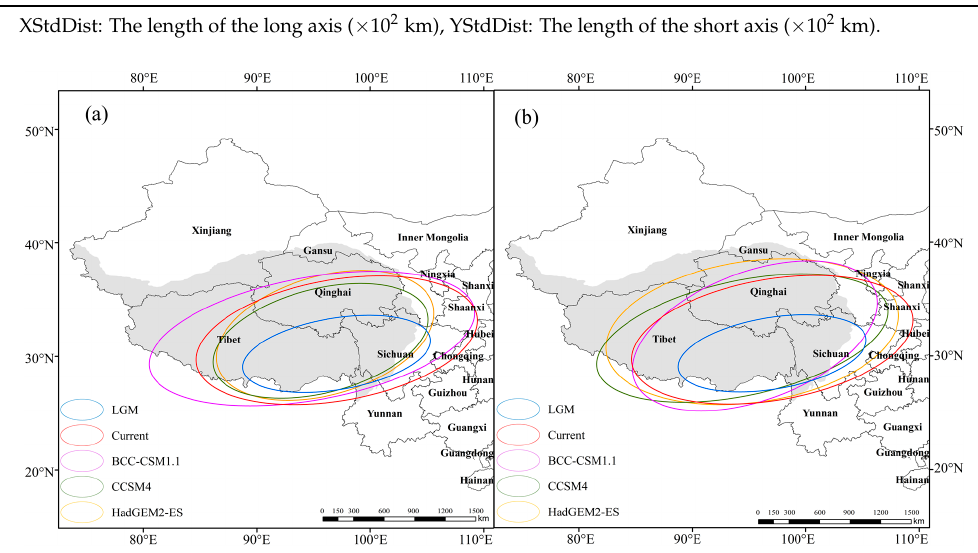
Figure 7. The distribution ellipses of suitable habitat of J. tibetica in different periods. ( a ) RCP2.6 Climate scenarios; ( b ) RCP2.6 Climate scenarios. As observed from the results of the centroid of the suitable habitat (Figure 8), the centroid of J. tibetica in the LGM was located in Basu County (Changdu City, Tibet, 97.04° E 30.22° N). From the LGM to the current, the centroid migrated northward to Karuo Dis- trict (Changdu City, Tibet, 97.06° E 31.42° N). In the future RCP2.6 scenario, the centroid of the BCC-CSM1.1, CCSM4 and HaDGEM2-ES climate models will be located in